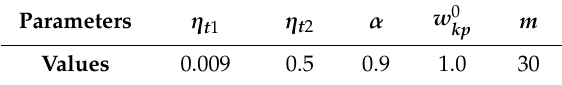
α η and learning rate 2 t αη ( , ) is set to (0.9, 0.5), t